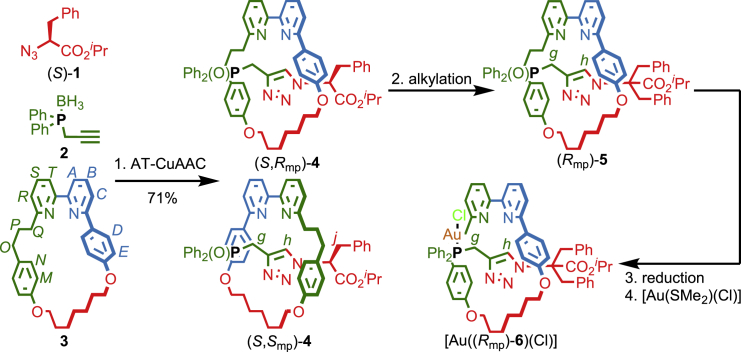
Synthesis of Mechanically Planar Chiral Rotaxane PrecatalystsReagents and conditions: (1) (i) [Cu(MeCN)4]PF6, 1H-sponge, CH2Cl2, room temperature (RT), 8 h; (ii) KCN, MeOH-CH2Cl2 (1:1), RT, 30 min; (iii) H2O2 (35% w/w in H2O), CH2Cl2, RT, 5 min. 72% combined yield over 3 steps prior to separation of diastereomers. (S,Rmp)-4: 30%, 98% ee, >99: <1 dr; (S,Smp)-4: 24%, (S,Smp)-4-(R,Smp)-4-(S,Rmp)-4 = 98.4:1.0:0.6. (2) LiHMDS, tetrahydrofuran, −78°C then, BnI, −78°C to RT, 18 h. (Rmp)-5: 81% (98% ee). (Smp)-5 63% (98% ee; data not shown, see Supplemental Information). (3) HSiCl3, NEt3, PhMe, CH2Cl2, 100°C, 3 days. (4) (Me2S)AuCl, CH2Cl2, RT, 1 h. (Rmp)-5: 64% yield over two steps (98% ee). (Smp)-6: 62% (98% ee; data not shown, see Supplemental Information).